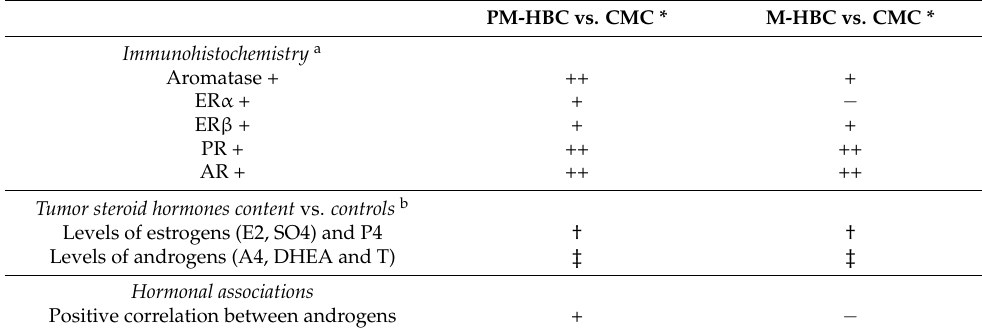
Table 5. Comparison of the expression of aromatase, hormonal receptors, and local steroid hormone content between human breast cancer and canine mammary cancer